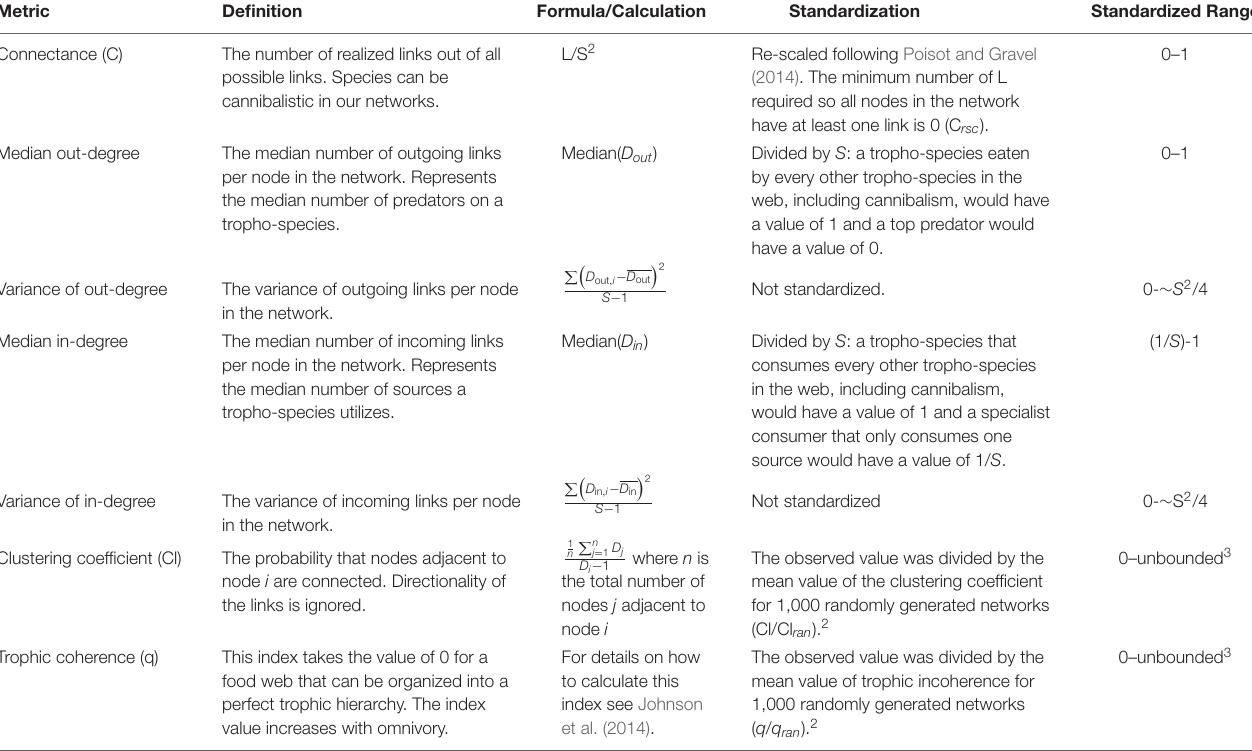
TABLE 1 | Metrics used to evaluate network topology, their definition, formula, and the standardization applied to reduce correlation with food web size. Metric